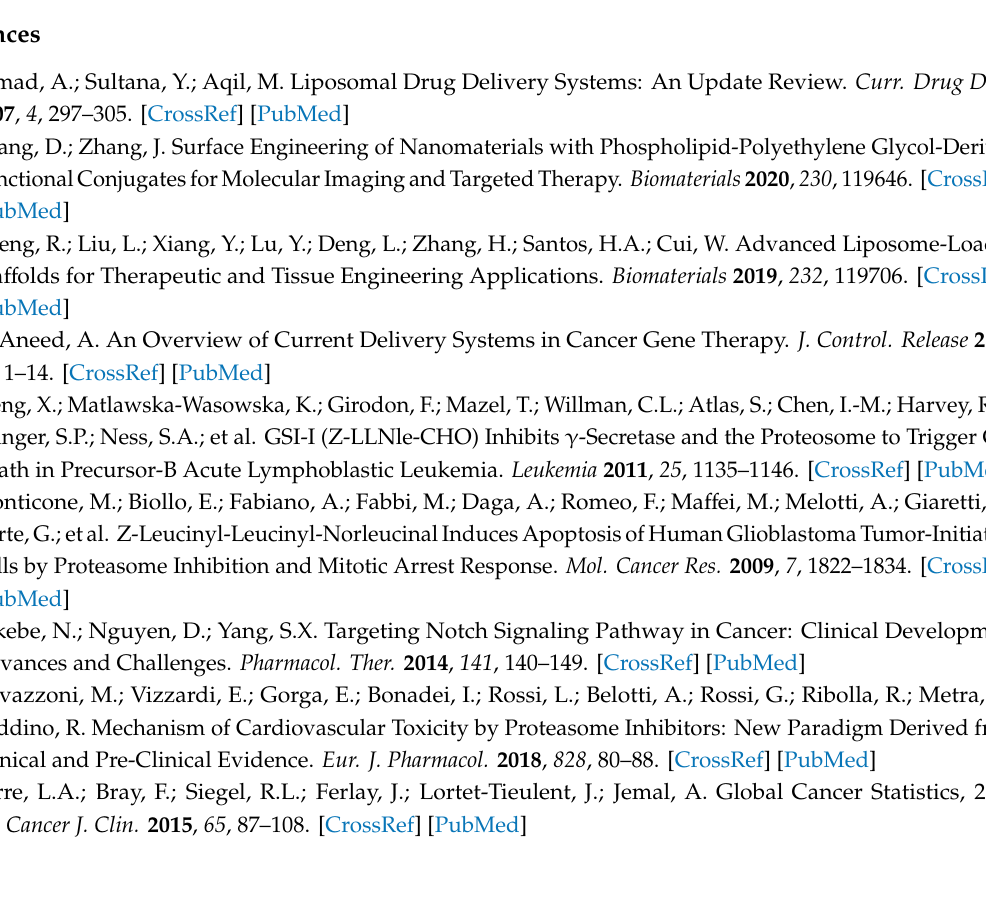
Table S1: results of statistical analysis, Figure S1: Immunofluorescence analysis of the GP2d cell line treated for 2 h with PBS control (A–F) or with Cxm-LLNle (G–L) and Figure S2: Immunofluorescence analysis of the LoVo cell lines treated for 2 h with PBS control (A–F) or with Cxm-LLNle